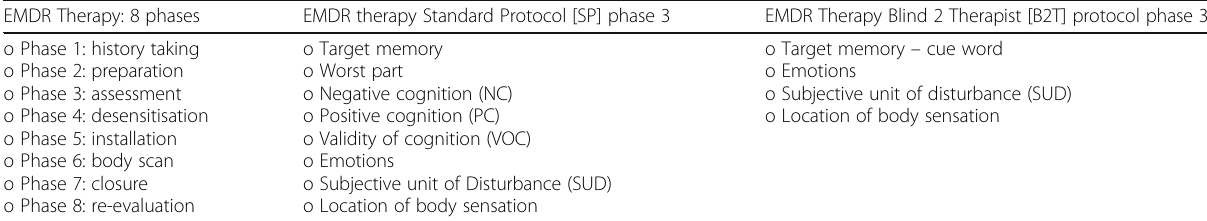
Table 2 Core components of the EMDR Therapy phases and protocols: Standard versus B2T EMDR Therapy: 8